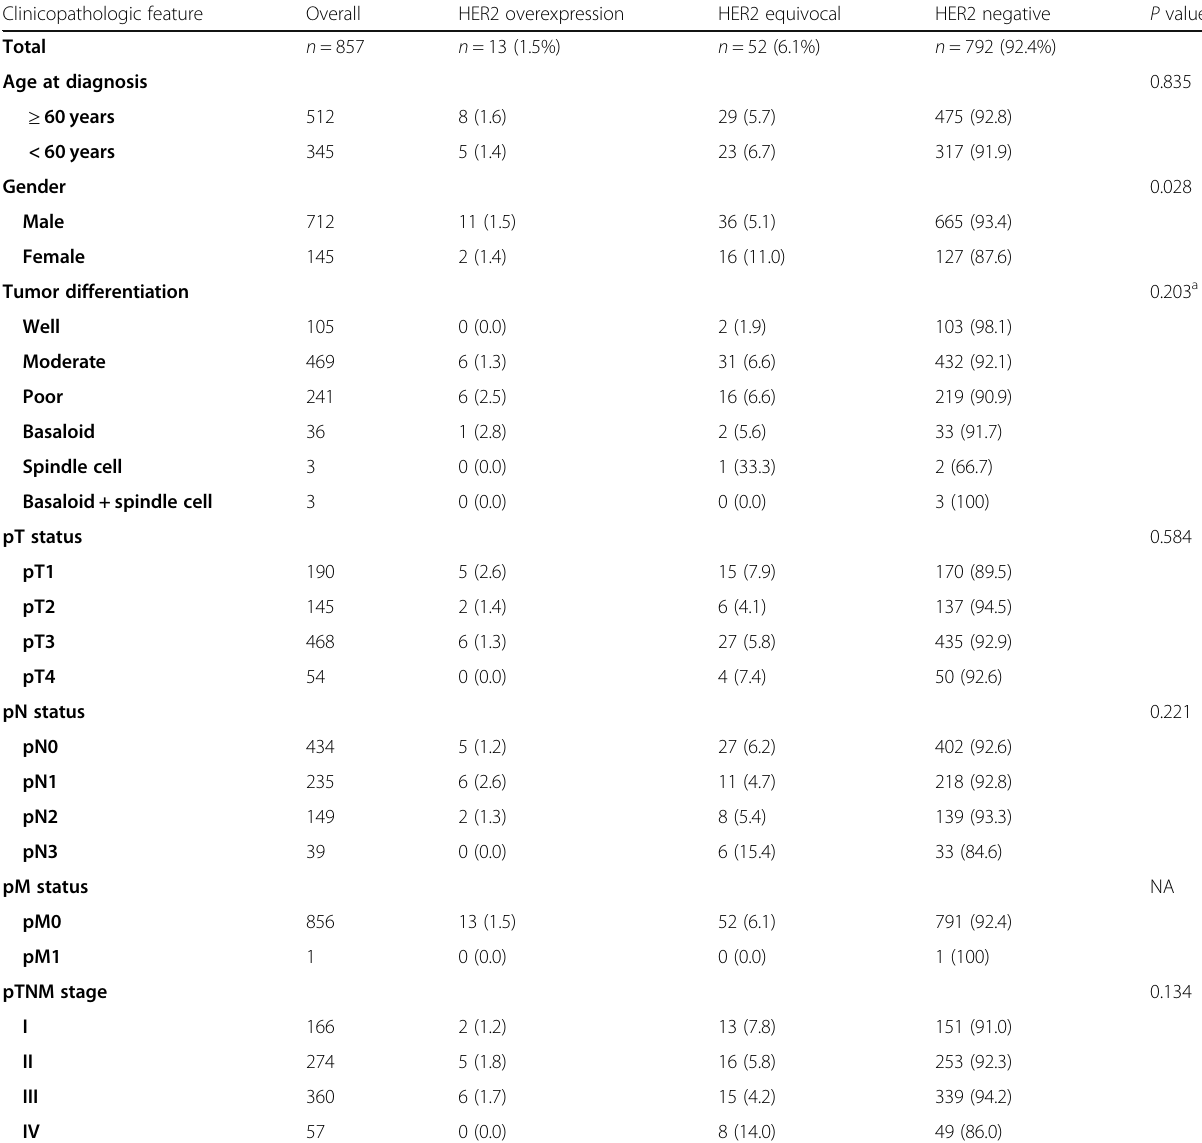
Table 1 Correlation between HER2 IHC expression status and clinicopathological parameters Clinicopathologic feature Overall HER2